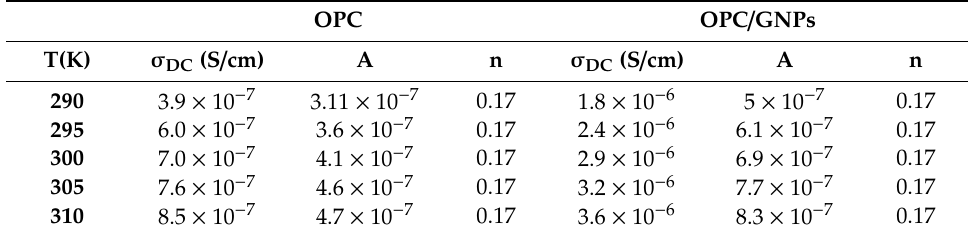
Figure 5. Electrical conductivity 𝜎′(𝜔) as a function of frequency in the temperature range 290–310 K of OPC ( a ) and OPC / GNPs ( b ). Table 2. Parameters obtained from the Arrhenius equation applied to data in Figure 5.